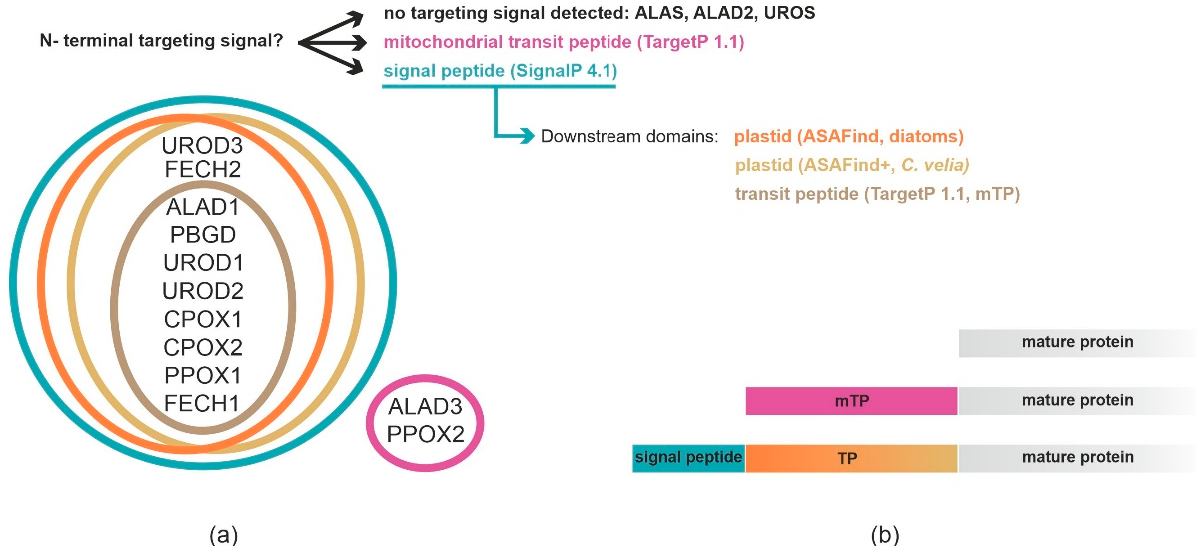
Figure 2. In silico targeting predictions for heme biosynthesis pathway enzymes in C. velia . ( a ) Euler diagram displays interpretation of targeting signals by various predictors. ( b ) Scheme showing different possibilities of N-terminal targeting signals.